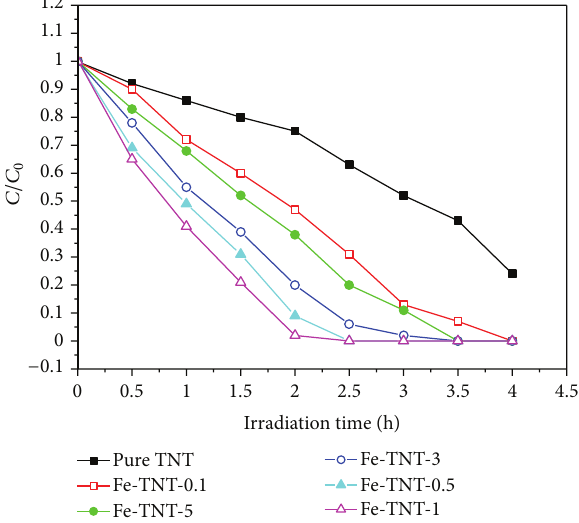
Figure 5: The photocatalytic activity of as-synthesized samples with different molar ratios of Ti:Fe under visible light